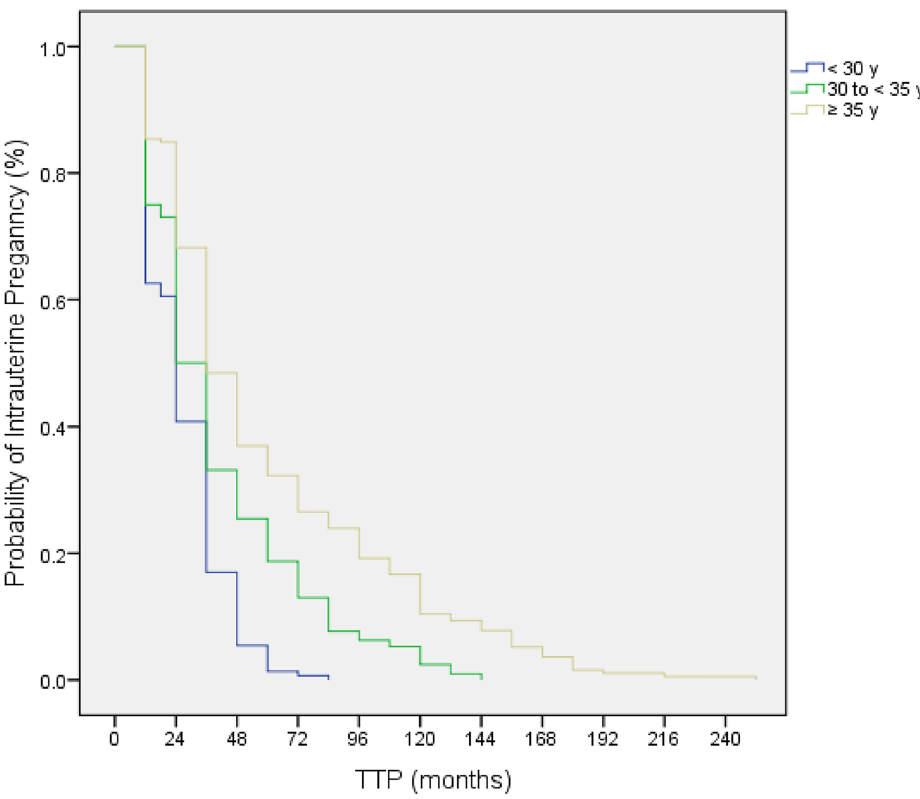
Figure 2. Kaplan–Meier curves for time to pregnancy in women with previous EP stratified by the maternal age. Log-rank (Mantel–Cox) comparison: P <